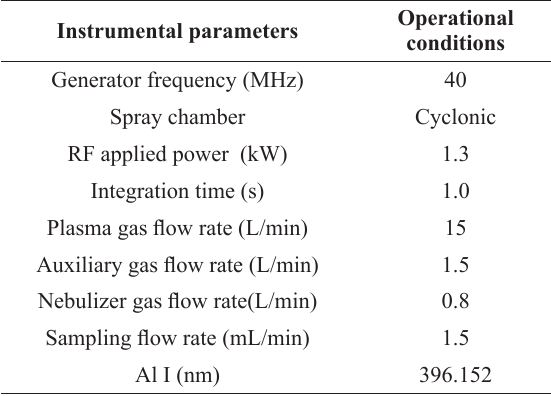
Operational conditions in ICP OES